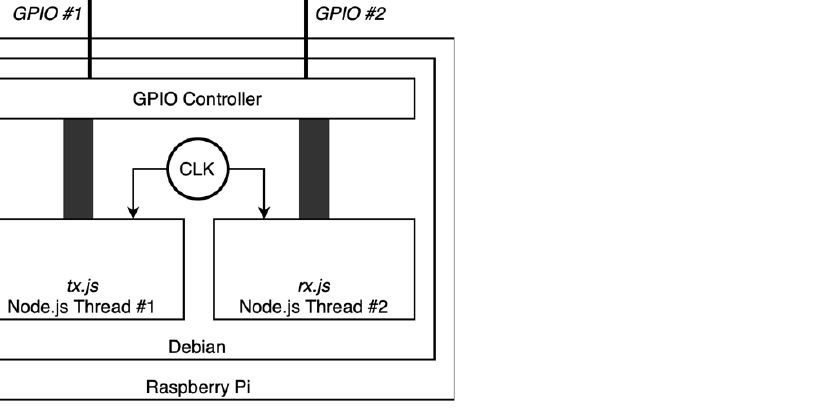
Figure 5. Hardware loop representation.